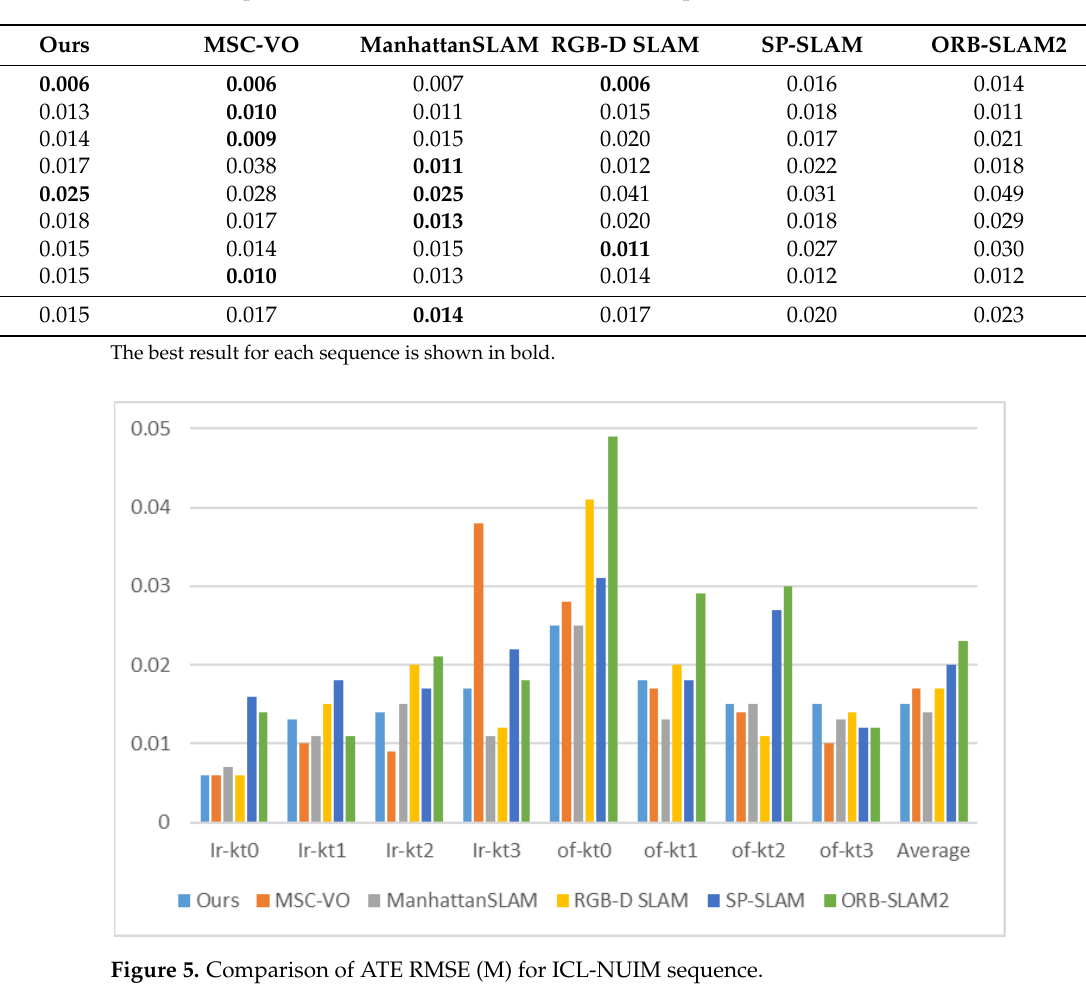
Table 2. Comparison of ATE RMSE (M) for ICL-NUIM sequence.